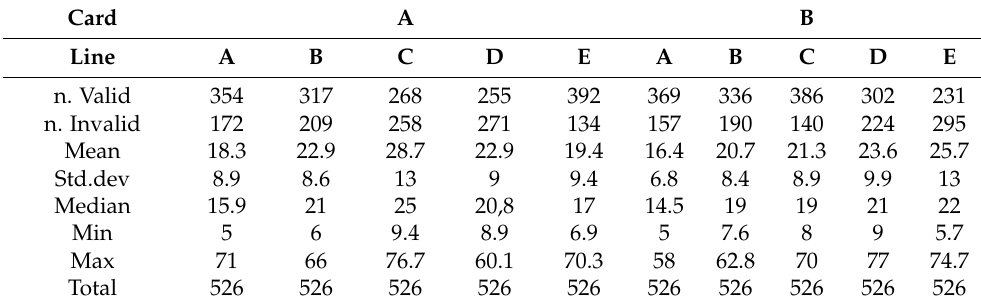
Table 3. Descriptive statistics of execution times for the GVT test separated for each Card and Line. Data are reported in seconds. n. Valid = number of the lines followed correctly; n. Invalid = lines followed incorrectly, missed or abandoned by the participants; Total = total number of